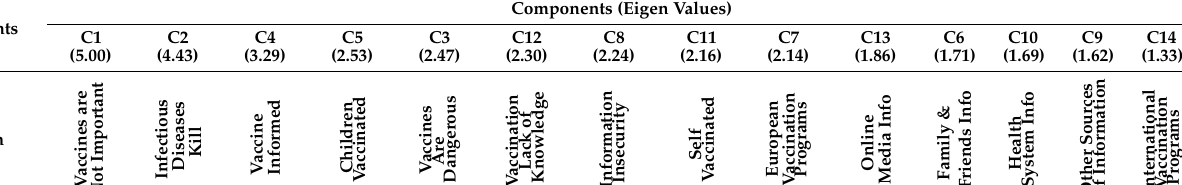
Table A2. PCA components loadings (VARIMAX